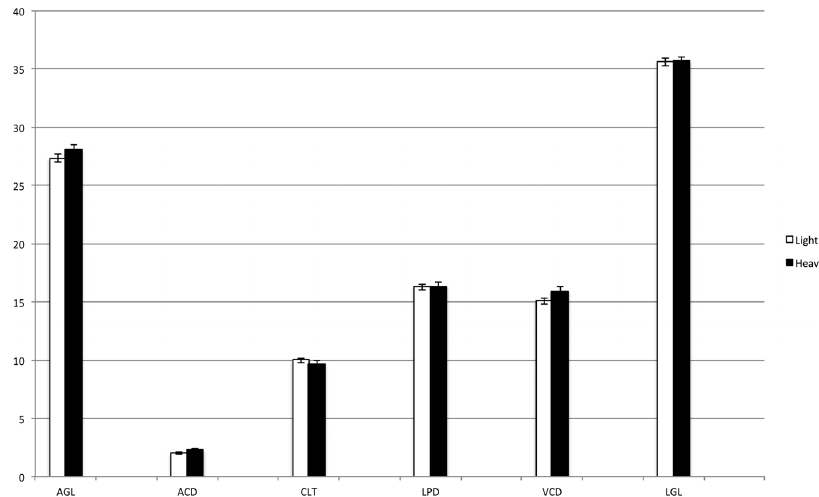
Figure 4. Intraocular measurements in relation to body weight. No significant differences were detected. Light , 48 kg bw (wh ite columns); heavy $ 48 kg bw (black columns). AGL=axial globe length; ACD=anterior chamber depth; CLT=central lens thickness; LPD=lens poles distance; VCD=vitreous chamber depth; LGL=longitudinal globe length.